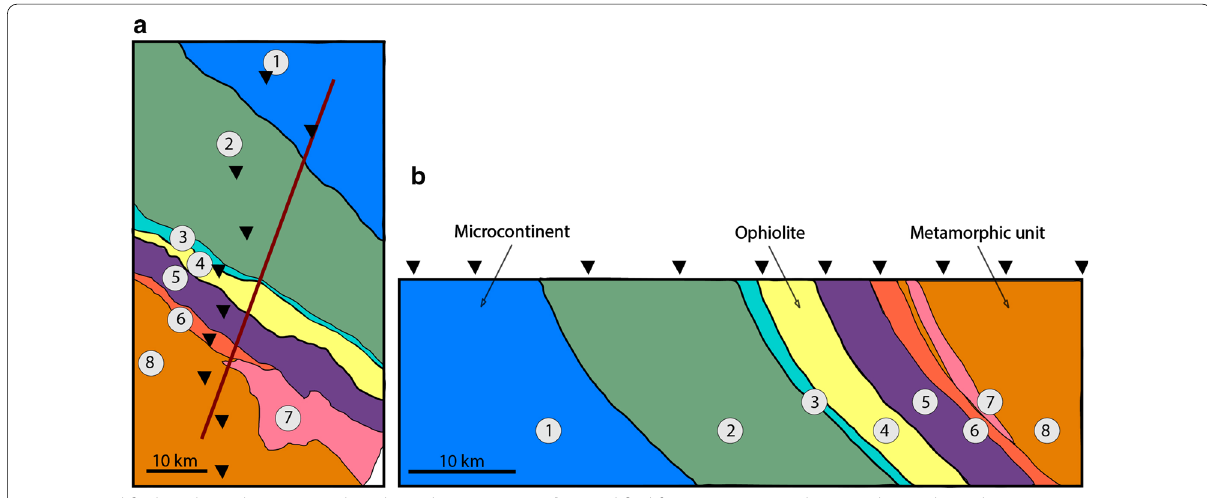
Fig. 2 Simplified geological map ( a ) and geological cross-section ( b ) (modified from Osozawa et al. 2008). The geological cross-section is coincident with profile L4000; its location is marked with a line on the map (see also Fig. 1). The locations of MT measurement sites are indicated with black triangles (along L4000). Several south-dipping lithotectonic units are identified. These include: (1) Hangai microcontinent; (2) Dzag metamorphic continental margin; (3) Haluut Bulg accretionary complex; (4) Bayankhongor Ophiolite Belt; (5) Delb Khairkhan accretionary complex; (6) Ulaan Sair volcanic unit; (7) Granite unit; (8) Burd Gol metamorphic